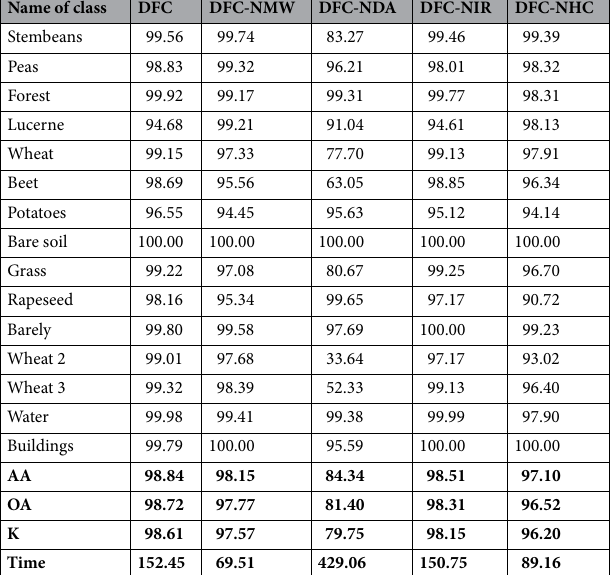
Table 1. Classification results for Flevoland dataset achieved by using 100 training samples per class.